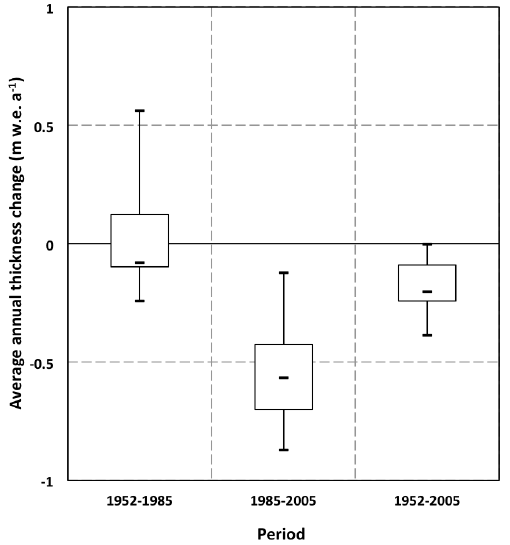
Figure 9. Box-and-whisker plots displaying maximum, interquar- tile range, median, and minimum of average annual thickness change in meters of water equivalent of seven glaciers for three pe- riods.